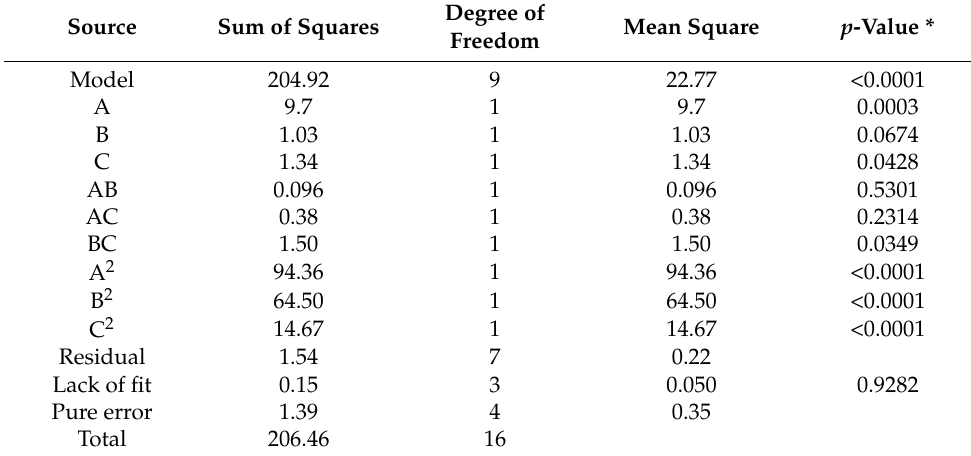
Table 2. Variance analysis and significance test of regression